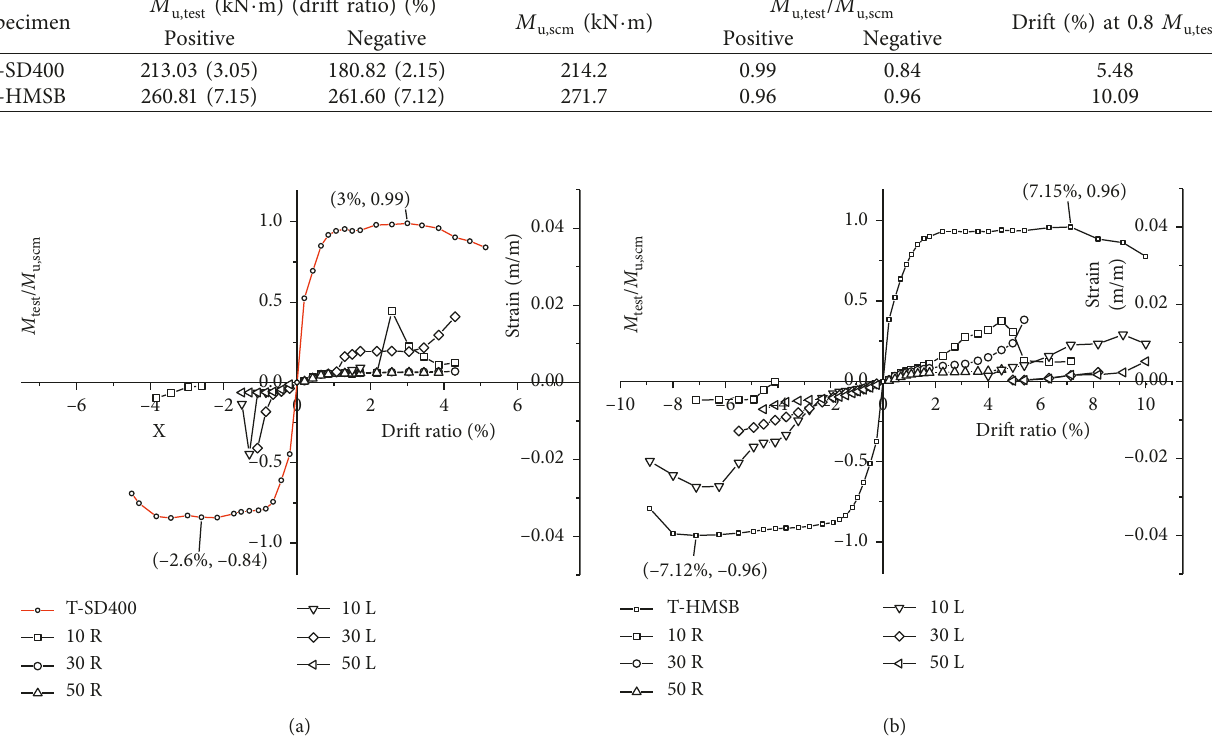
Figure 12: Strain distributions in reinforcing bars with the M